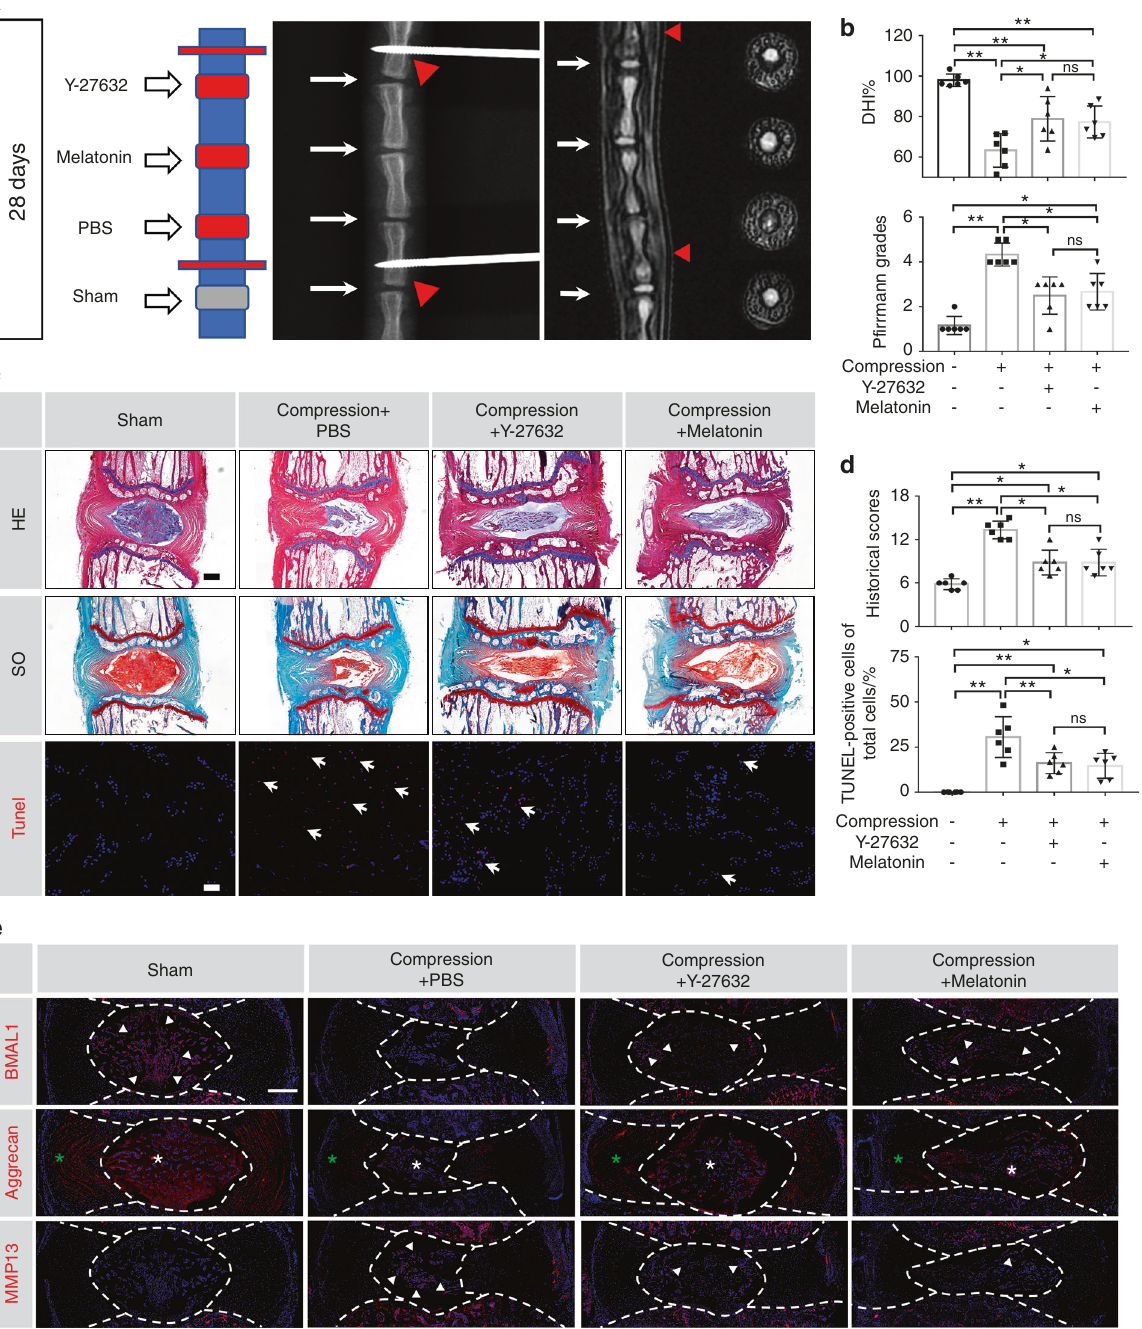
Fig. 6 Y-27632 and melatonin restore the expression of BMAL1 and ameliorate the IDD process in a compression-induced rat model. a Representative X-ray and MRI images of rat coccygeal vertebrae on Day 28 after surgery and a schematic diagram of the operation. White arrows: points of injection; red sticks and red triangles: external fi xation points; red squares: compressed discs; gray squares: uncompressed discs. b Statistical graphs of DHI% and P fi rrmann grades. Differences among multiple groups were analyzed by one-way ANOVA and Kruskal- Wallis h-tests. c Representative HE, SO, and TUNEL staining images. Scale bar: 500 μ m. d Statistical graphs of histological scores and the percentage of TUNEL-positive cells. Differences among multiple groups were analyzed by Kruskal-Wallis h-tests and one-way ANOVA. e Representative images of immuno fl uorescence of BMAL1, Aggrecan and MMP13. Central parts of these graphs encompassed by white dotted lines indicate NP tissues. White arrows: BMAL1- or MMP13-positive cells. White asterisk: Aggrecan-positive area in NP tissue. Green asterisk: Aggrecan-positive area in AF tissue. The data in the fi gures represent the mean ± S.D. ns not signi fi cant, ** P < 0.01, * P < 0.05, n = ameliorate excessive loading-induced circadian disruption of NP reported that melatonin could alleviate IDD by disrupting the IL- cells by inhibiting the RhoA/ROCK pathway and thus attenuate the 1 β /NF- κ B-NLRP3 in fl ammasome positive feedback loop 52 . Our process of IDD. Considering the side effects of systemic results also con fi rmed the protective effects of melatonin on the administration, intradiscal injections were accepted. process of IDD and further demonstrated that melatonin could